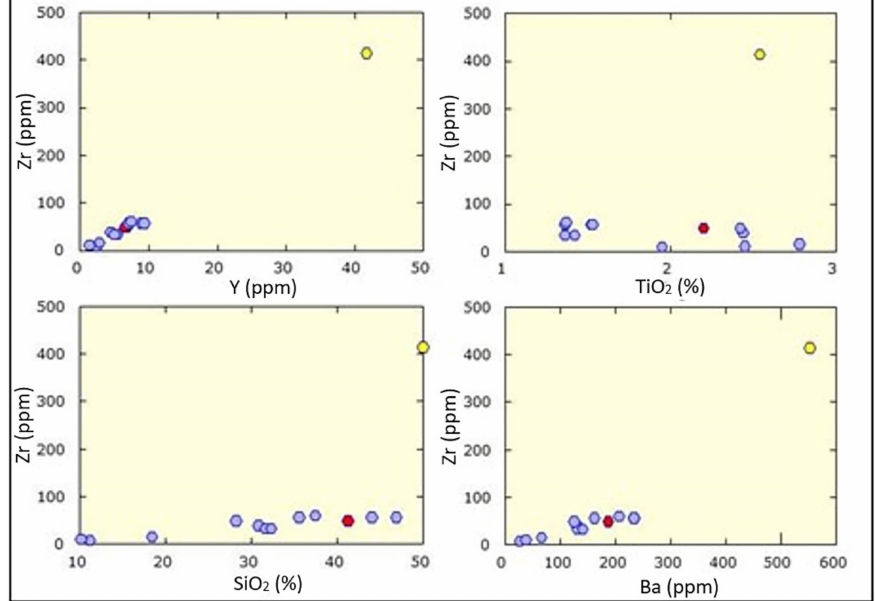
Figure 5. Immobile element variation diagrams for samples from hole VB95-129; the anorthosite sample (5.06–5.15 m) is yellow, the gossan sample (3.4–3.48 m) is red, and the gabbro-troctolites are